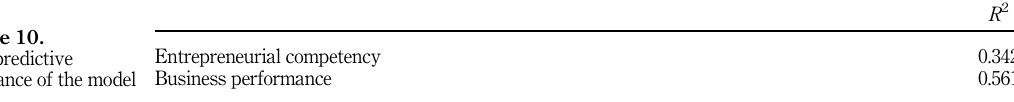
Table 10. The predictive relevance of the